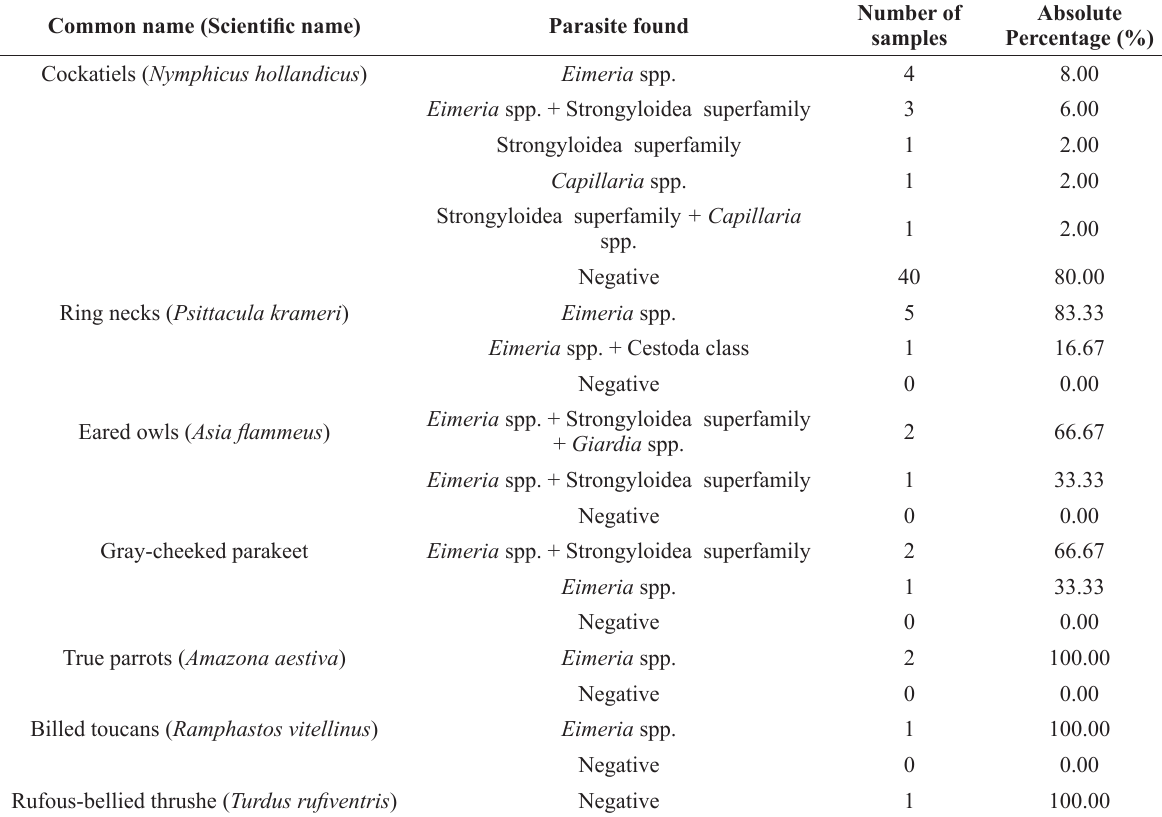
Parasites diagnosed in birds samples of Paraná State, Brazil,